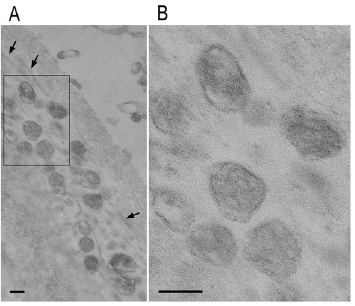
Figure 7. Transmission electron microscopy of human TM tissues. Transmission electron microscopy image of human TM tissue prepared from surgically transected material. ( A ) Exosomes are located in a cluster in the extracellular space. Arrows indicate collagen fibers. ( B ) Enlargement of the framed area in ( A ). Vesicles are enclosed by a limiting membrane that shows a typical profile of the lipid bilayer. Scale bars: 100